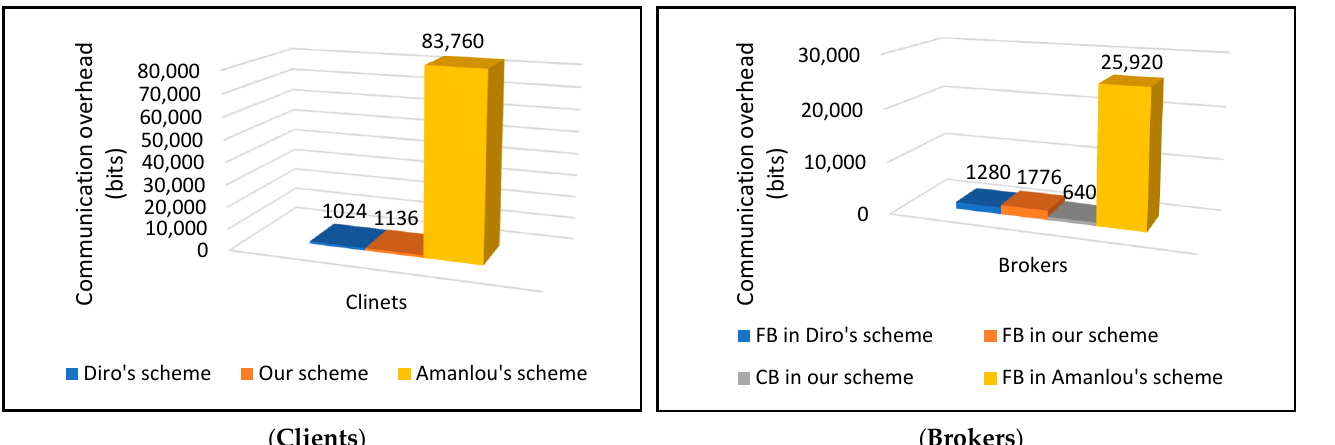
Figure 13. Communication overhead for clients and brokers in Diro’s scheme, our scheme, and Amanlou’s scheme.